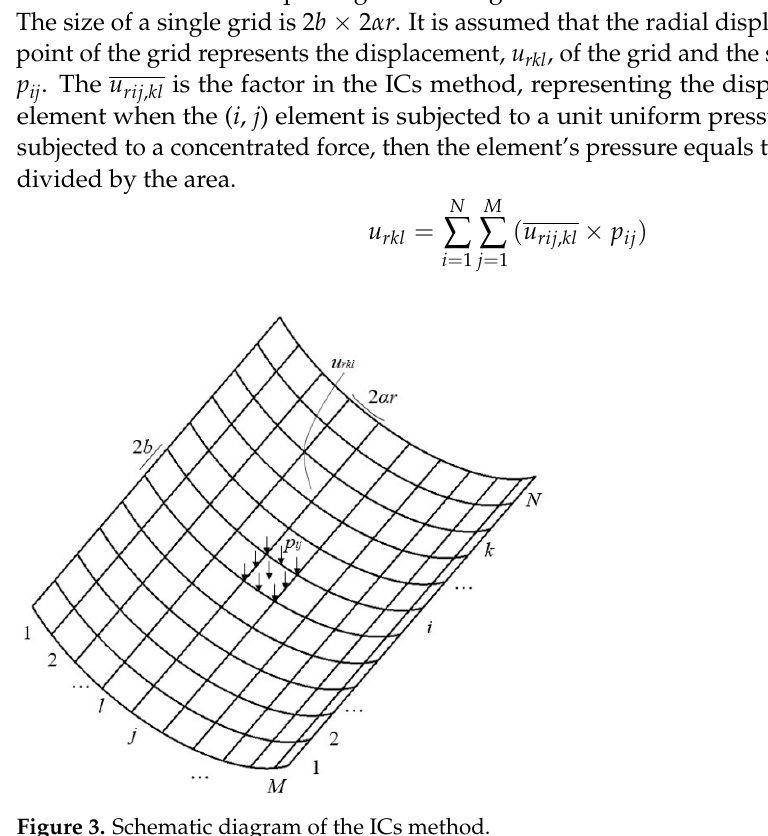
Figure 3. Schematic diagram of the ICs method.